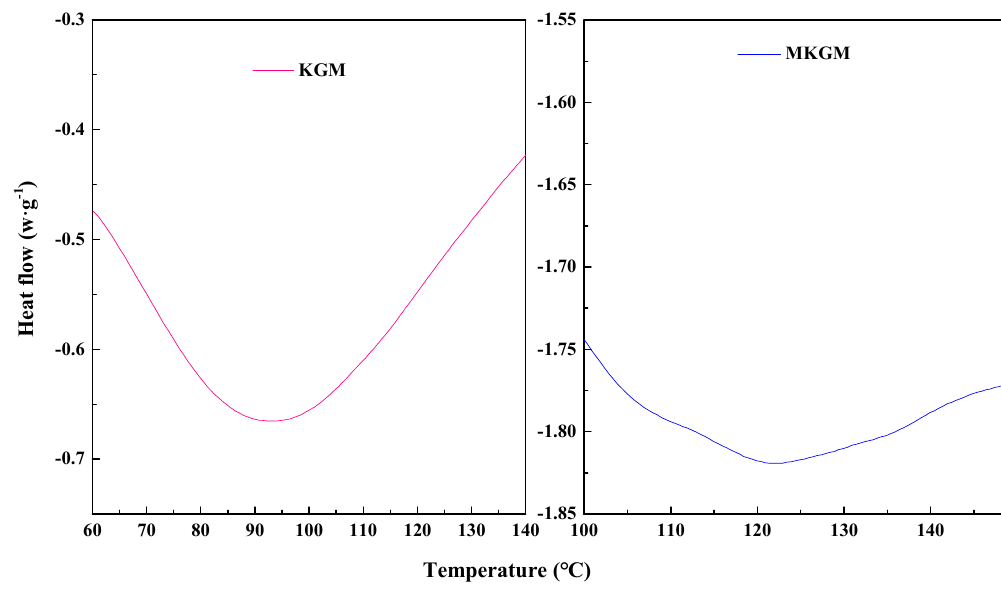
Figure 5. DSC curves of KGM and MKGM.